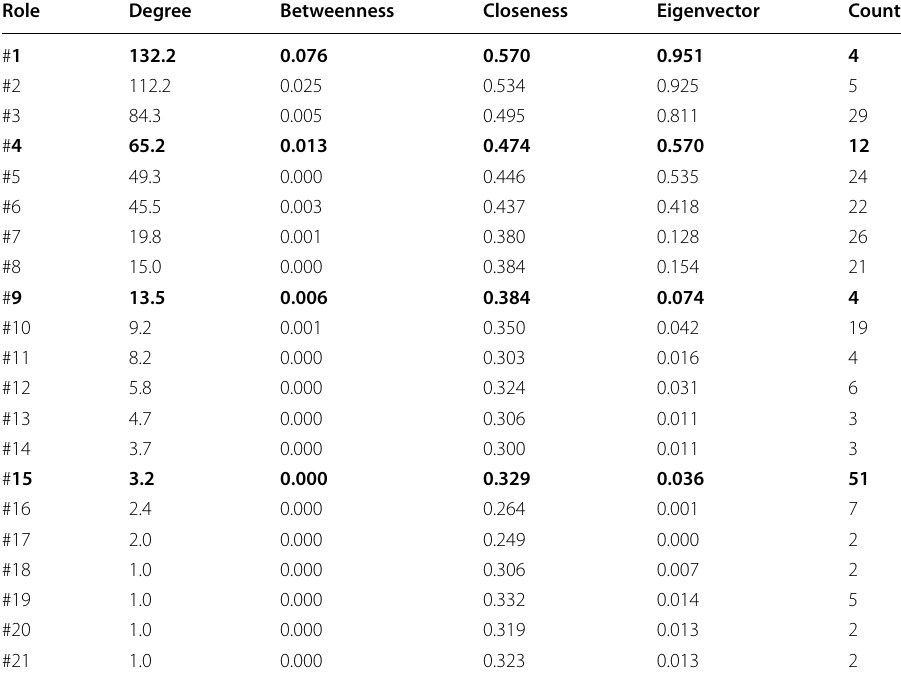
Table 3 Roles identified in COVID-19 related research and their mean network attributes, including centrality scores and cluster size (count)